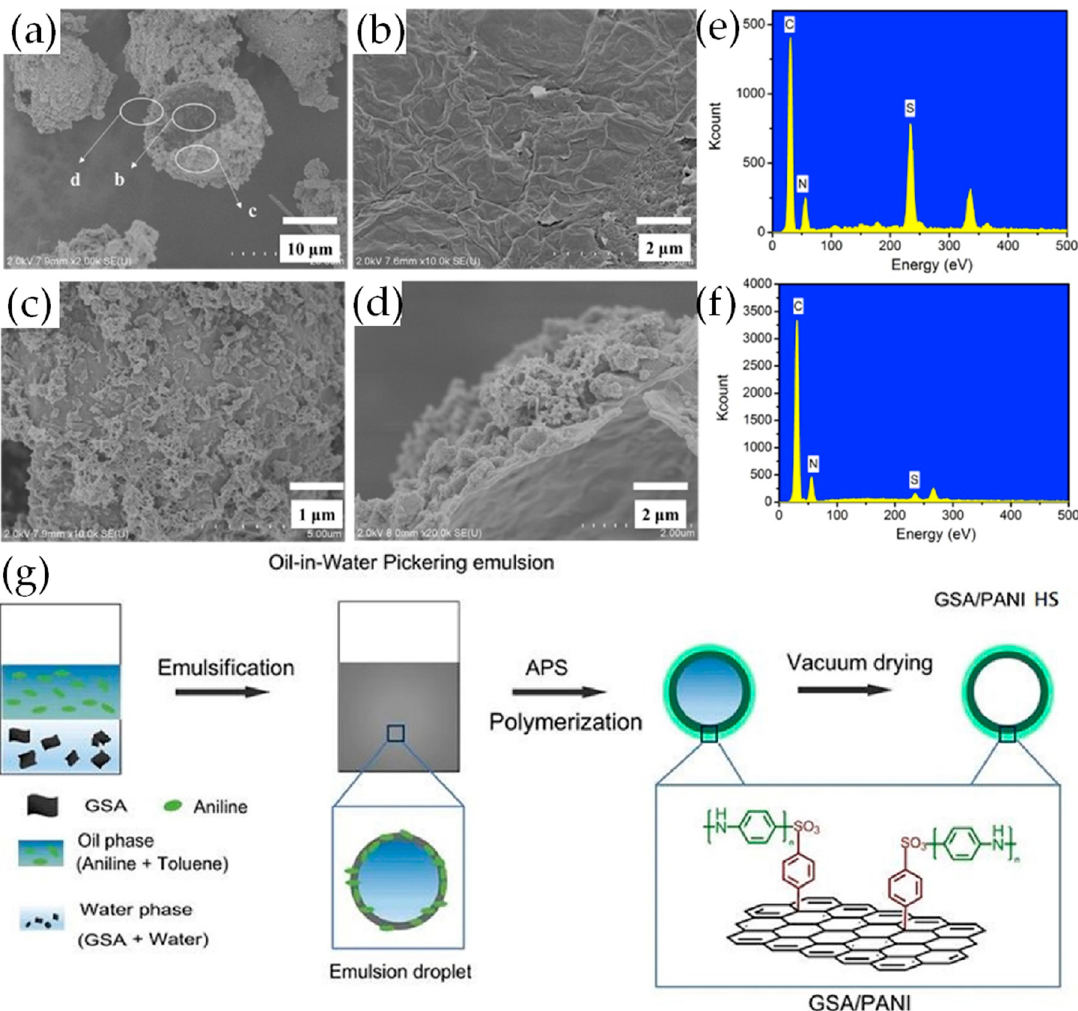
Figure 3. ( a ) GSA/PANI HS FE-SEM images of; FE-SEM images of ( b ) inner wall, ( c ) outer wall and ( d ) edge of GSA/PANI HS; ( e ) EDX spectrum of the regions of GSA/PANI HS inner wall; ( f ) EDX spectrum of the regions of GSA/PANI HS outer wall; ( g ) Schematic illustration of the fabrication of GSA/PANI HS via Pickering emulsion route; Reproduced with permission from [53]. Elsevier (2018).